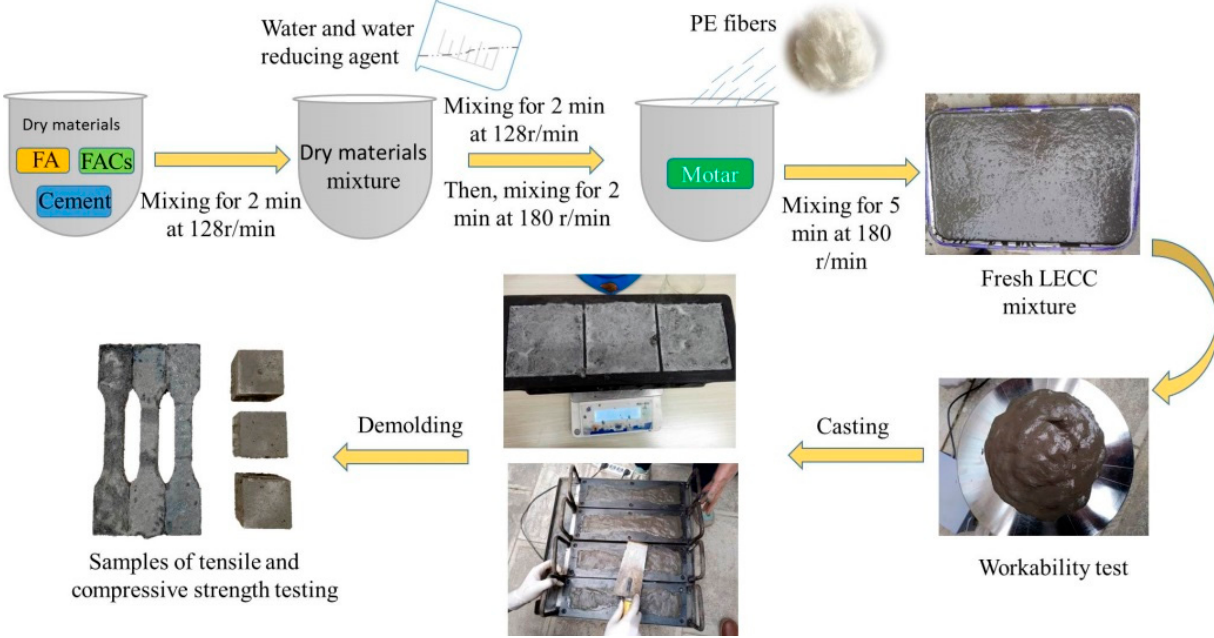
Figure 3. Sample preparation procedure.